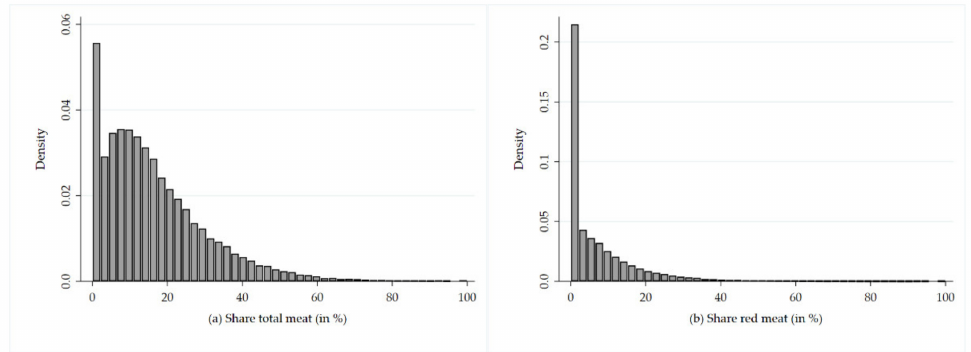
Figure 1. Density distribution of the dependent variables ( a ) share of total meat consumption (in %) and ( b ) share of red meat consumption (in %).